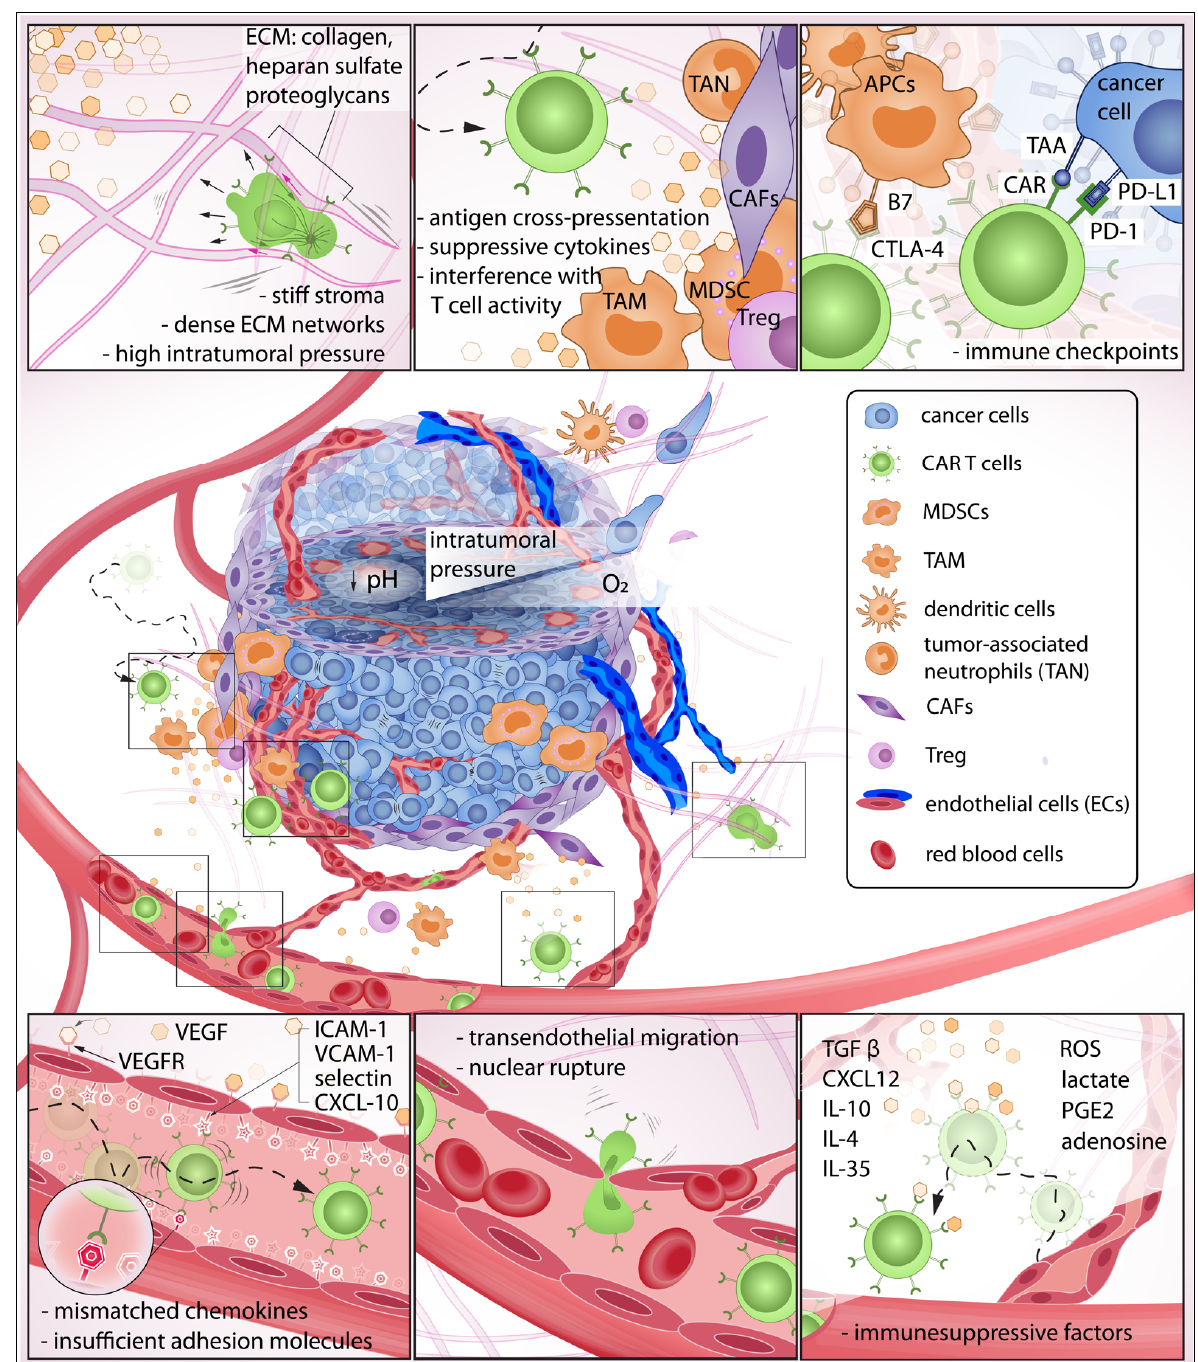
Figure 1. The exhausting journey of CAR T cells in the TME: In this journey, CAR T cells must be able to detect chemokines at the tumor site, effectively roll and adhere to the blood vessel wall, initiate transendothelial migration, and invade the tumor stroma. Here, the immune cells must overcome various biochemical and physical barriers to then encounter pro-tumor cells that suppress CAR T cell activity. Some CAR T cells may eventually make contact with target cancer cells that express abundant immune checkpoints, further reducing anti-tumor function.